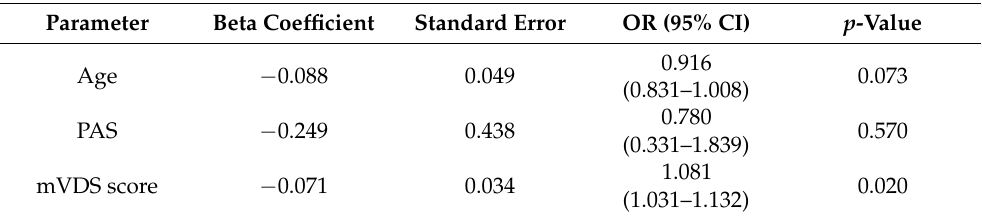
Table 3. Multivariate logistic regression analysis (with the enter method) of the association between the modified version of the videofluoroscopic dysphagia scale scores and the allowance of the oral feeding